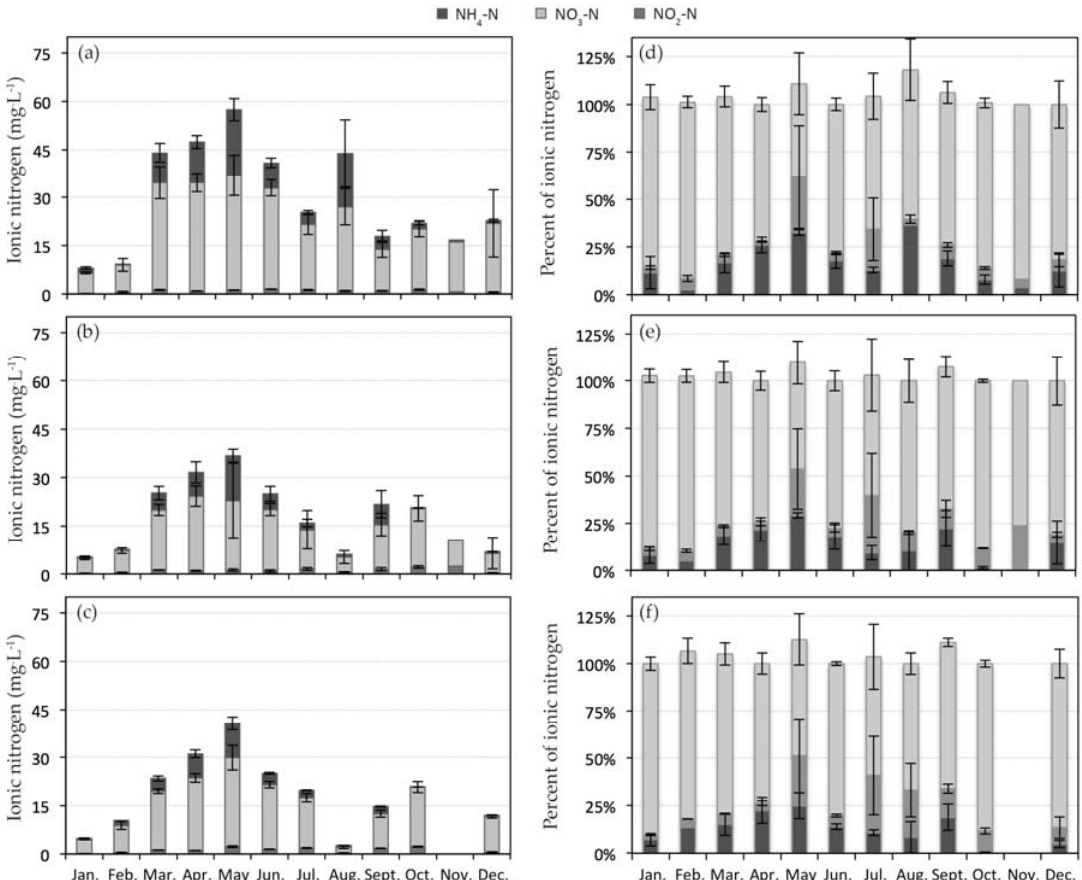
Figure 6. The concentration and percent of ionic nitrogen [nitrite (NO 2 -N), nitrate (NO 3 -N) and ammonium (NH 4+ -N)] detected within Sites 1.1, 1.2, and 1.3 in Constructed Wetland 2 (CW2): ( a , d ) Site 1.1 (inflow ditch/runoff channel); ( b , e ) Site 1.2 (retention pond); and ( c , f ) Site 1.2 (direct inflow to Stage 1 of CW2). Error bars represent the standard error ( ± ) of the mean value.